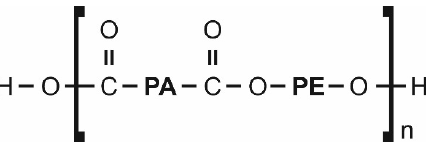
Figure 1. Chemical structure of polyether block amide (Pebax ® 2533); PA—polyamide group, PE— polyether group.